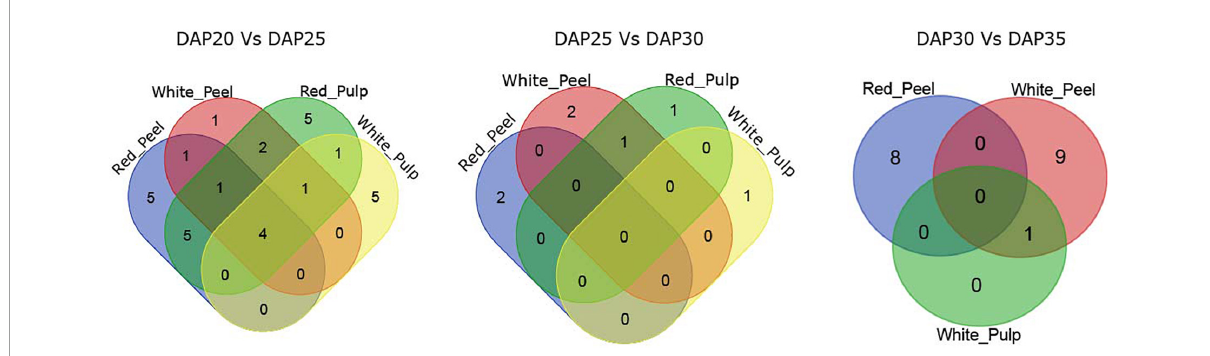
FIGURE4 Overlapping enriched kyoto encyclopedia of genes and genomes (KEGG) pathways among pitaya development of DEGs between white and red pitaya.